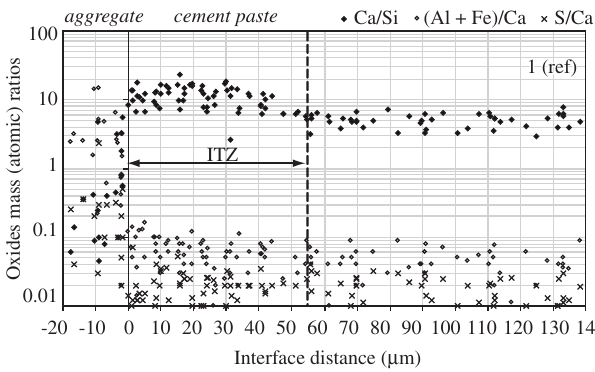
Figure 2. The ratios of Ca/Si, (Al + Fe)/Ca and S/Ca to concrete 1 (ref.).